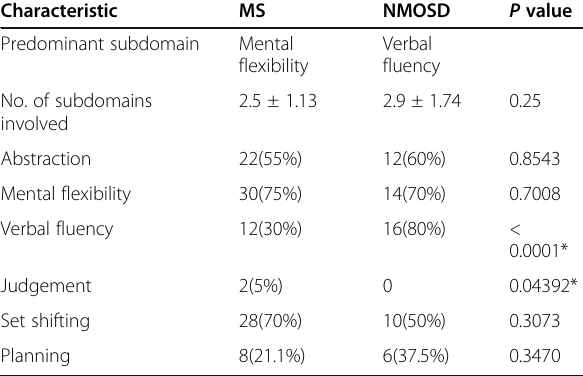
Table 4 Executive profile of NMOSD vs MS patients